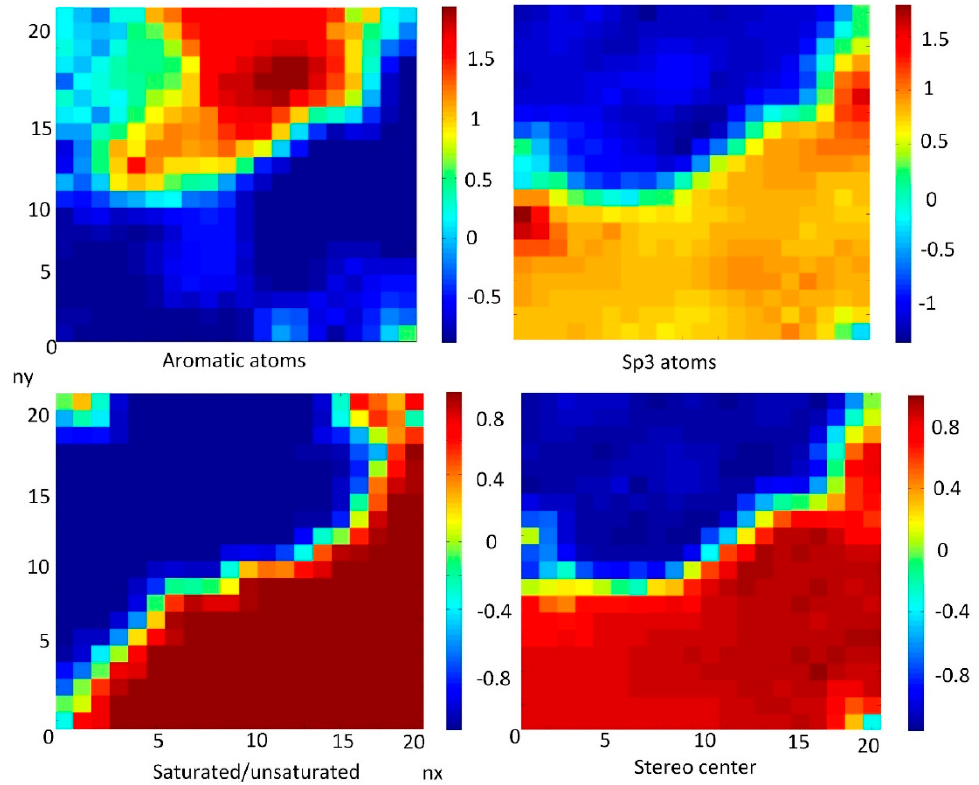
Figure 10. Weight maps of descriptors: aromatic atoms, sp3 atoms, stereo centers with distribution of saturated / unsaturated